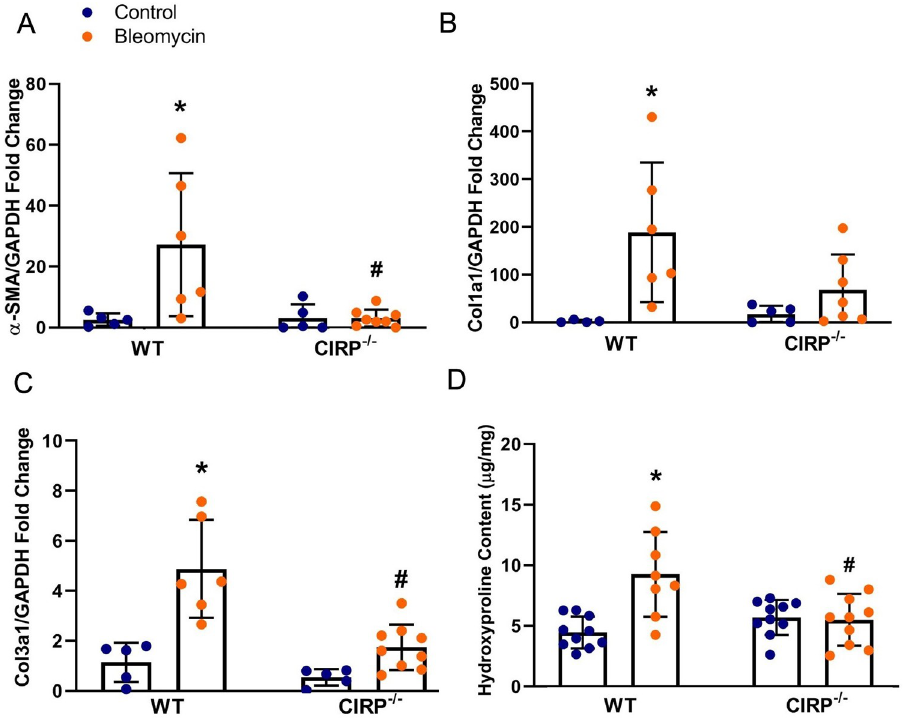
Fig 2. Deficiency in CIRP attenuates molecular markers of lung fibrosis in mice exposed to bleomycin. For α -SMA ( A ), Col1a1 ( B ), and Col3a1 ( C ) mRNA expression data, total RNA was isolated using Trizol reagent and reverse transcribed to cDNA using M-MLV (Moloney murine leukemia virus) reverse transcriptase. Glyceraldehyde 3-phosphate dehydrogenase (GAPDH) RNA was used to normalize the amplification data and fold changes were calculated in comparison with WT Control mice using the 2 (- ΔΔ Ct) method. For the hydroxyproline assay, a calorimetric Hydroxyproline assay kit was used to measure hydroxyproline content from samples prepared from ~100 mg of lung tissue lysates from each mouse ( D ). � p < 0.05 vs. Wild Type (WT) Control, # p < 0.05 vs. WT Bleomycin. Data were analyzed using a two-way analysis of variance (ANOVA) followed by Tukey’s multiple comparison test